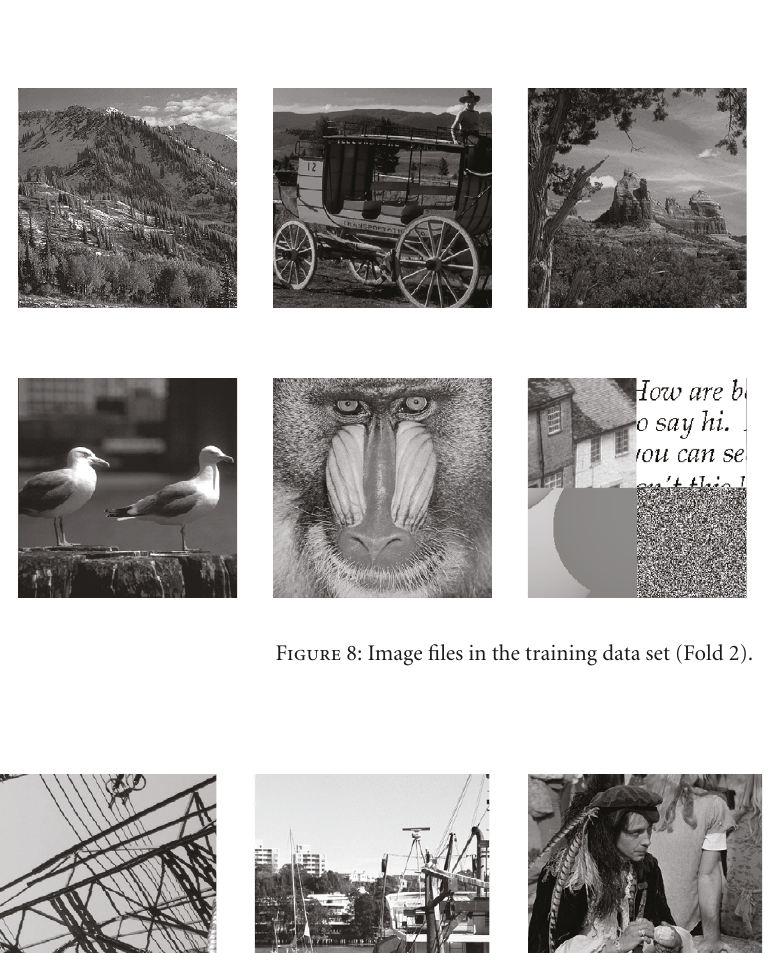
Figure 7: Image files in the training data set (Fold 1).